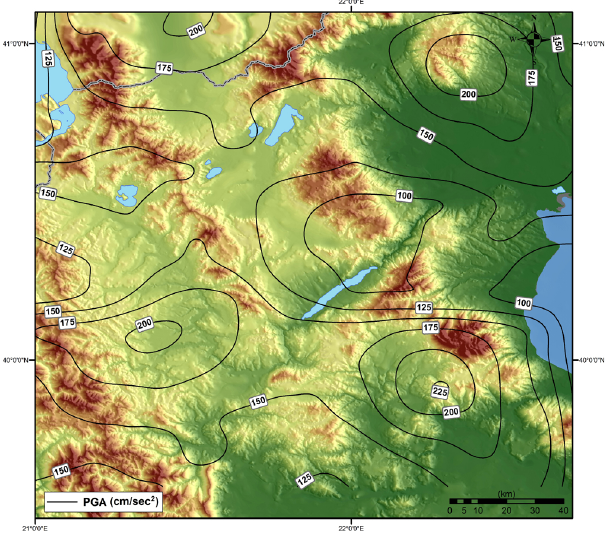
Fig. 5. Peak ground acceleration (cms − 2 ) with probability 90% of not being exceeded in 50yr (Return Period = 475yr) for the period